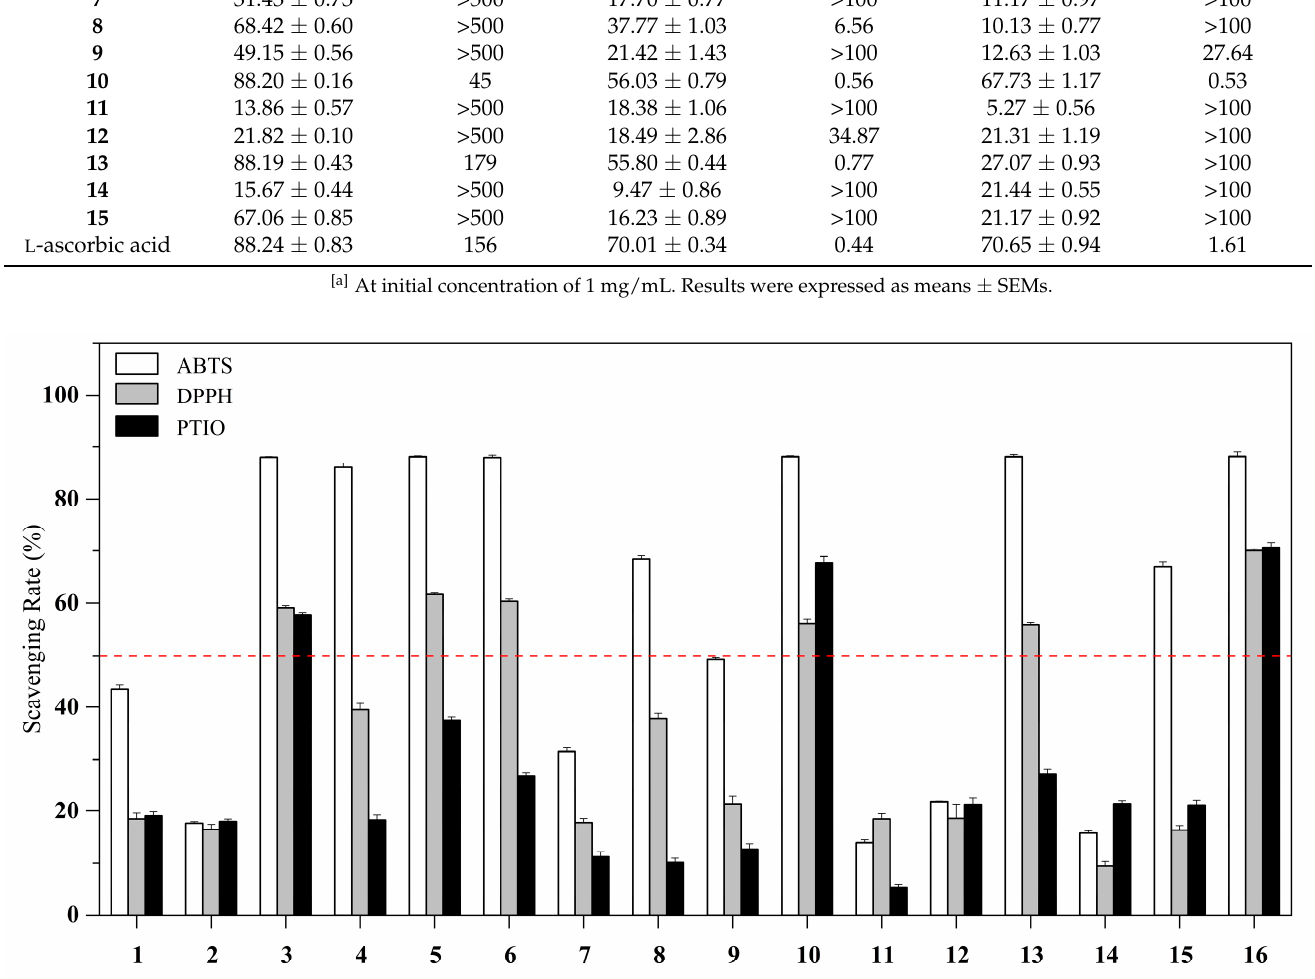
Figure 4. ABTS, DPPH and PTIO radical scavenging activities of compounds 1 – 15 and 16 ( L -ascorbic acid), at initial concentration of 1 mg/mL.